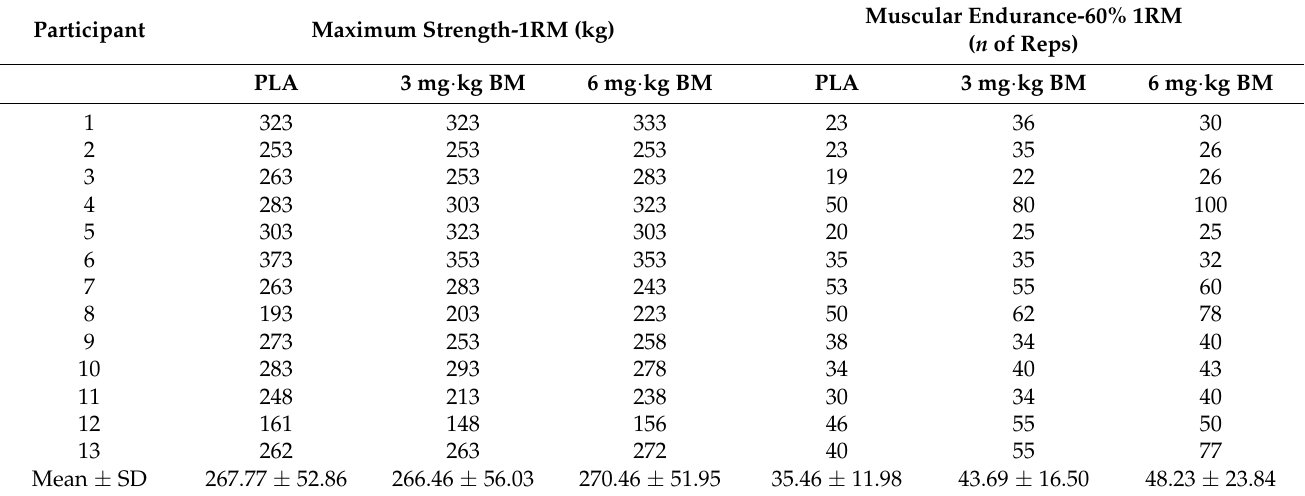
Figure 2. ( A ). 1RM ( B ). Number of reps completed and ( C ). Total volume lifted during the leg press exercise in strength-trained females, with PLA, 3 and 6 mg·kg − 1 BM. * p < 0.05 condition effect. RPE data were only analysed up until rep 20 (Figure 3), as this was the final multiple